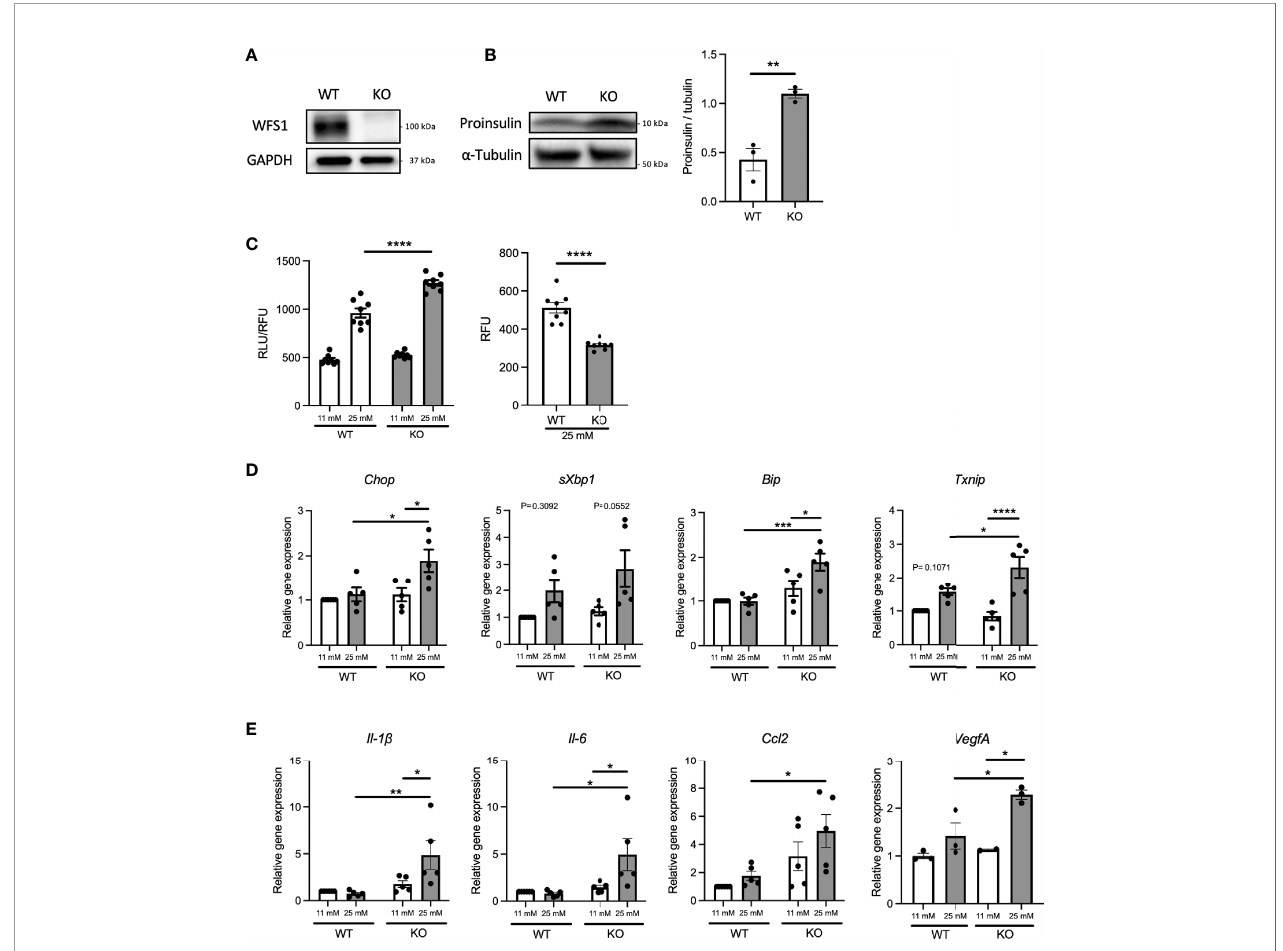
FIGURE 2 | Hyperglycemia upregulates pro-in fl ammatory cytokine genes expression in Wfs1 -de fi cient pancreatic b -cells. (A) Immunoblot images of WFS1 in Wfs1 wild-type (WT) and knockout (KO) INS-1 832/13 cells. (B) Left panel: Immunoblot images of proinsulin in WT and KO INS-1 832/13 cells treated with 25 mM glucose for 1 h. Right panel: Proinsulin band intensity was quanti fi ed and normalized to tubulin (n=3). (C) Left panel: Caspase-3/7 activity normalized to cell viability in WT and KO INS-1 832/13 cells treated with 11 mM or 25 mM glucose for 48 h (n=8). Right panel: Cell viability of WT and KO INS-1 832/13 cells treated with 25 mM glucose for 48 h (n=8) (D) mRNA expression levels of Chop , sXbp1 , Bip , and Txnip in WT or KO INS-1 832/13 cells treated with 11 mM or 25 mM glucose for 48 h (n=3-5), normalized to 18srRNA . (E) The mRNA expression level of Il-1 b , Il-6 , Ccl2 , and VegfA in WT and KO INS-1 832/13 cells treated with 11 mM or 25 mM glucose for 48 h (n=3-5), normalized to 18srRNA . Data are shown as mean ± SEM, *P < 0.05, **P < 0.005, ***P < 0.001, ****P <